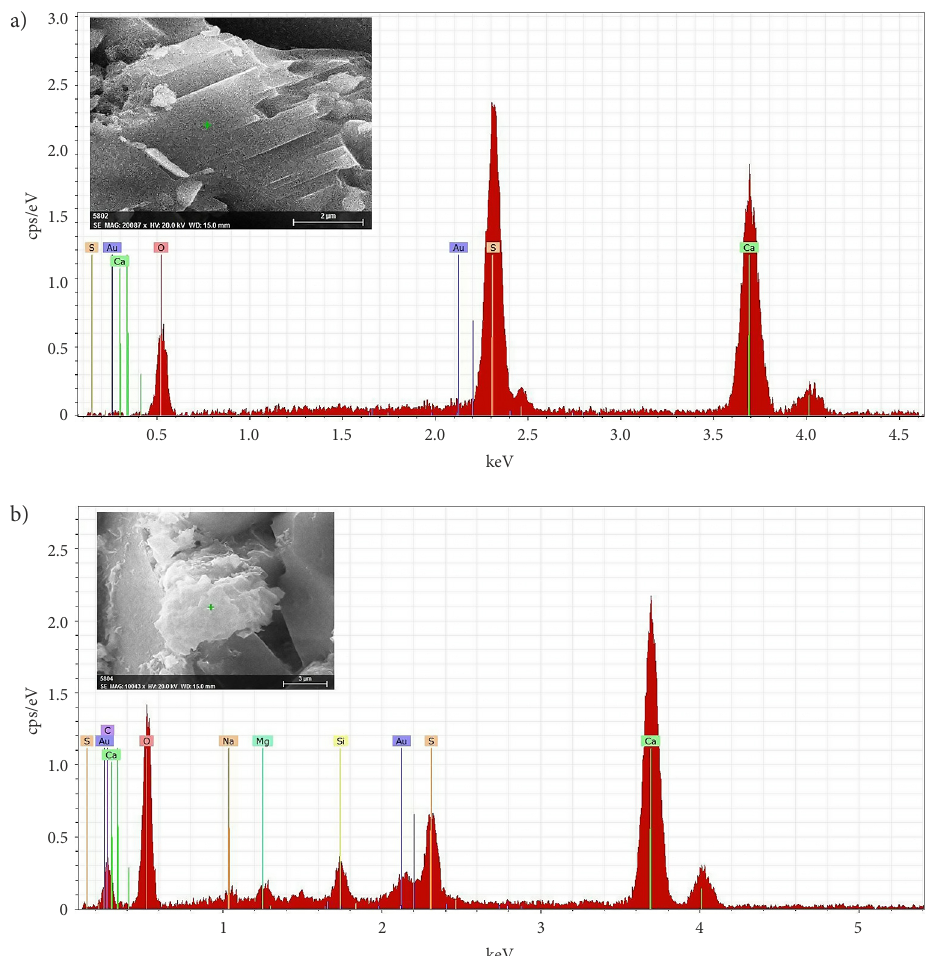
Figure 3. X-ray microanalysis of the microstructure of plasticized compositions: (a) – on the surface of crystalline hydrates, (b) – on the surface of amorphous structures the material significantly reduced and the water